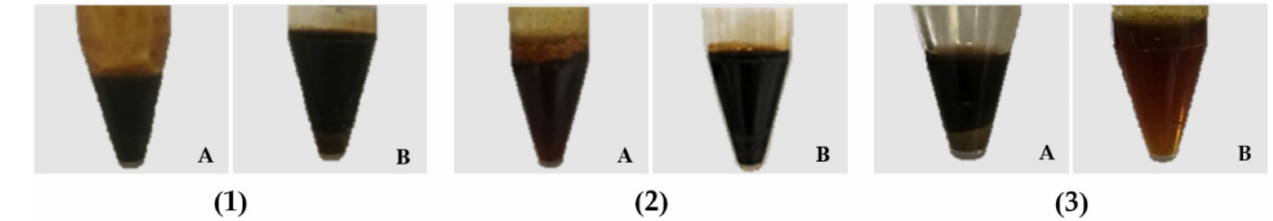
Figure 1. The physical appearance of the ethanolic ( A ) and aqueous ( B ) crude extracts of C. militaris from sample A ( 1 ) C. militaris was obtained from the Mushroom research and development center, Chiang Mai, Thailand), sample B ( 2 ) C. militaris fruiting body mixed with substrate was obtained from the Mushroom research and development center, Chiang Mai, Thailand) and sample C ( 3 ) C. militaris fruiting body mixed with substrate was obtained from Chiang Rai, Thailand).